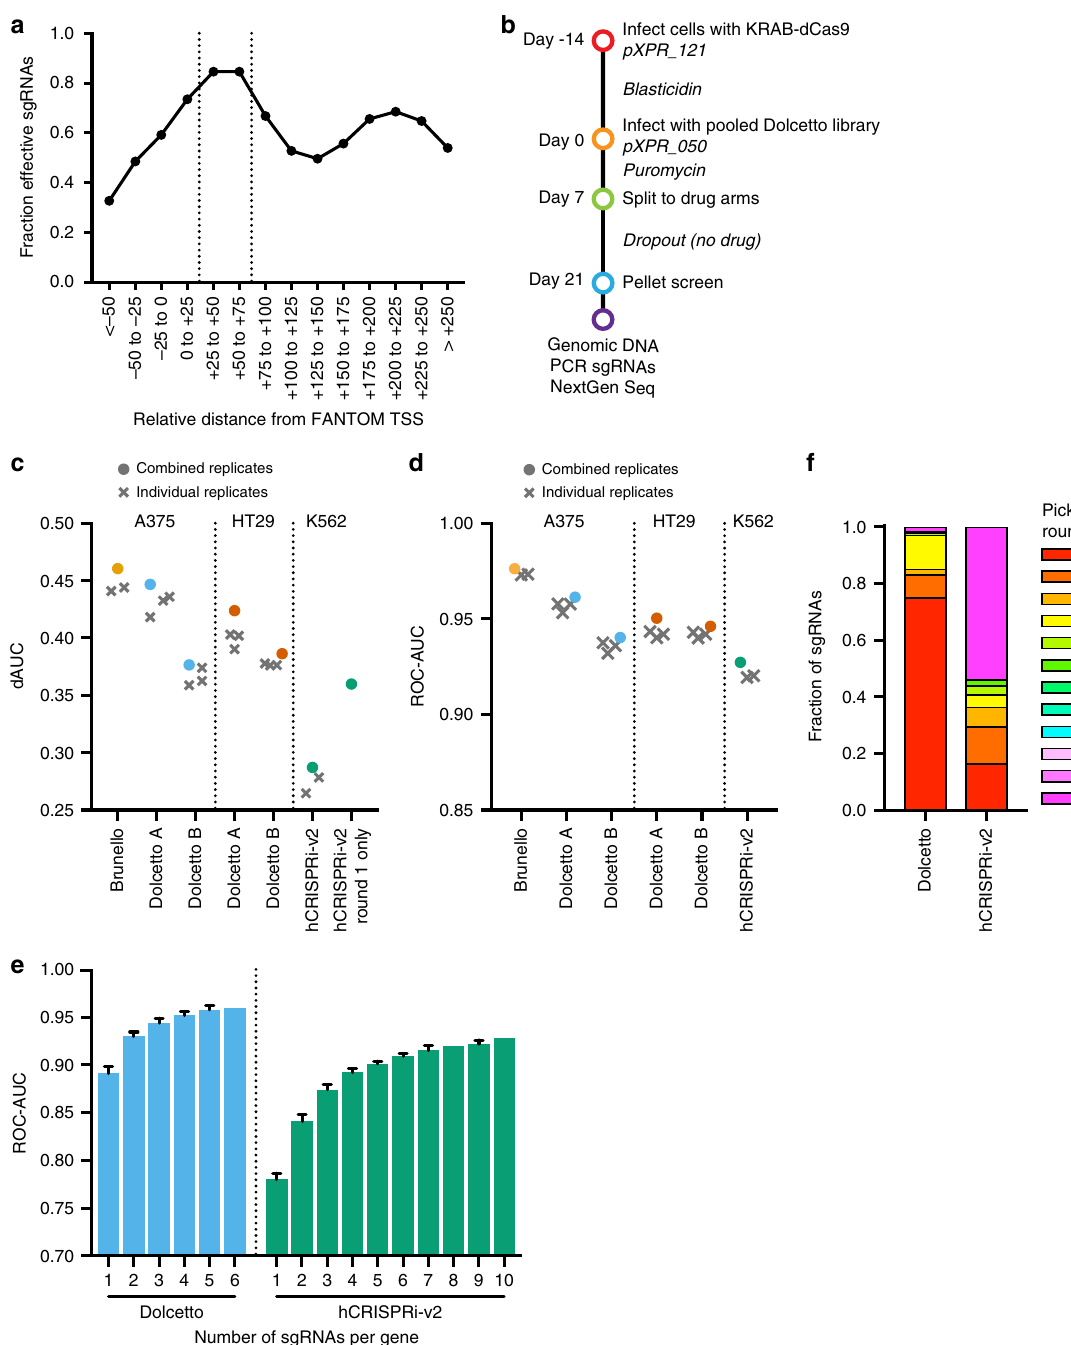
Fig. 3 CRISPRi screening with Dolcetto. a Comparison of sgRNA activity as a function of distance from the FANTOM-annotated transcription start site (TSS). Vertical dotted lines indicate the preferred targeting site. b Schematic of viability screens performed with Dolcetto in two cell lines. c dAUC comparison of sgRNA-level performance across CRISPRi libraries by cell line. dAUC values of individual replicates are plotted as X ’ s while dAUCs calculated using the average log2-fold change of replicates are plotted as circular points. For hCRISPR-v2 Round 1 only, the dAUC of the hCRISPR-v2 sgRNAs that would be picked in round 1 of our selection heuristic is plotted. Brunello dAUC values are plotted for comparison. d ROC-AUC comparison of gene-level performance across CRISPRi libraries by cell line. ROC-AUC values of individual replicates are plotted as X ’ s while ROC-AUCs calculated using the average log2-fold change of replicates are plotted as circular points. Brunello ROC-AUC values are plotted for comparison. e Subsampling analysis, calculating the ROC-AUC of n sgRNAs per gene in Dolcetto and hCRISPRi-v2. Error bars represent s.d. calculated from different iterations of library sampling. f Fraction of sgRNAs selected in each round using the heuristics described in Supplementary Table 2 for Dolcetto and